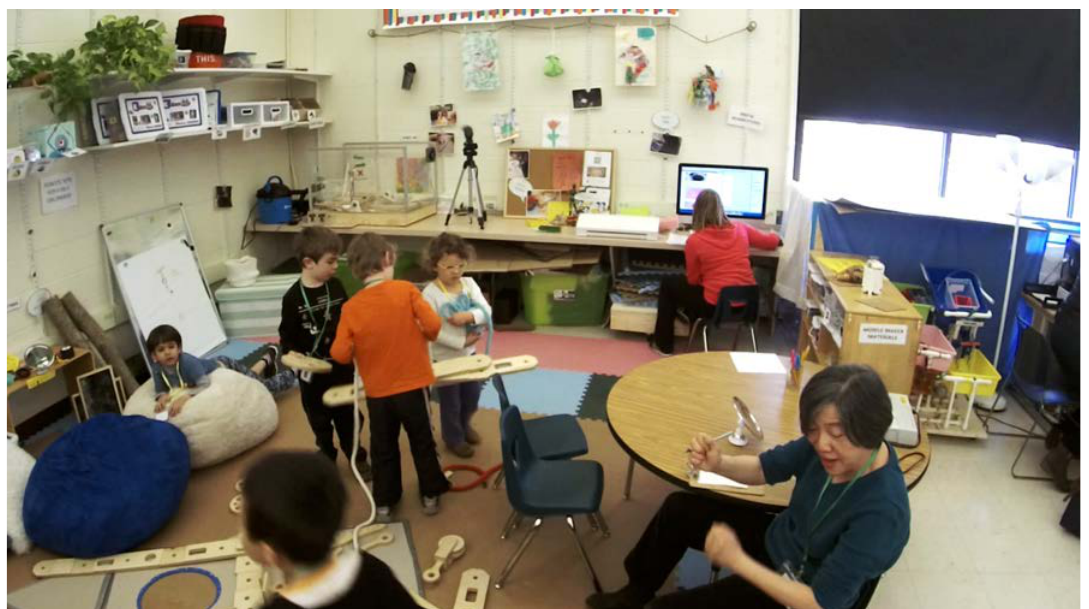
Figure 2. Children from the Eliot-Pearson Children’s School engage in unstructured making at the Early Childhood Makerspace (Image reprinted with author permission from Bers et al.,